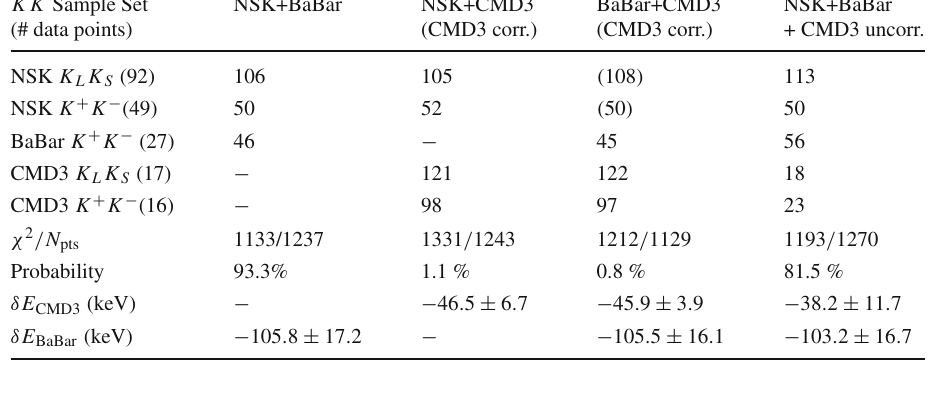
Table 2 BHLS 2 fit properties in the kaon sectors. The kaon data from NSK, BaBar and CMD-3 are fitted pairwise combined. The χ 2 values are displayed for individual channels or for the total number of data points N pts . In the two rightmost data columns, the top entry is δ E CMD3 and the bottom one δ E BaBar . The rightmost column